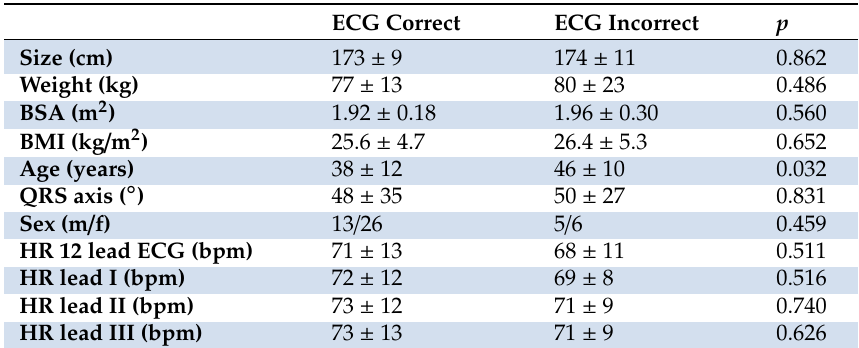
Figure 4. Comparison of typical standard Einthoven I–III leads from standard ECG (black ECG curves) and Apple Watch ECGs I–III (red ECG curves). Table 2. Correlations between correct ECG assumption and study population characteristics (BSA = body surface area, BMI = body mass index, HR = heart rate). P values were obtained by t -test, ANOVA and χ 2-test. Probability limit 95%.